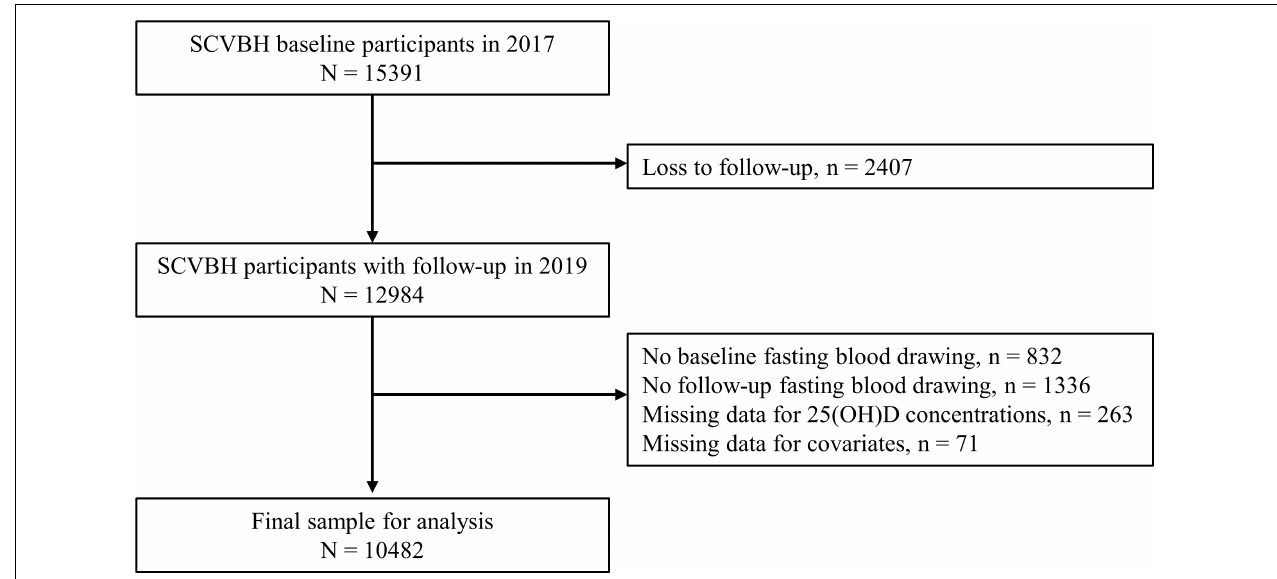
FIGURE 1 | Flow diagram of SCVBH cohort and analytic